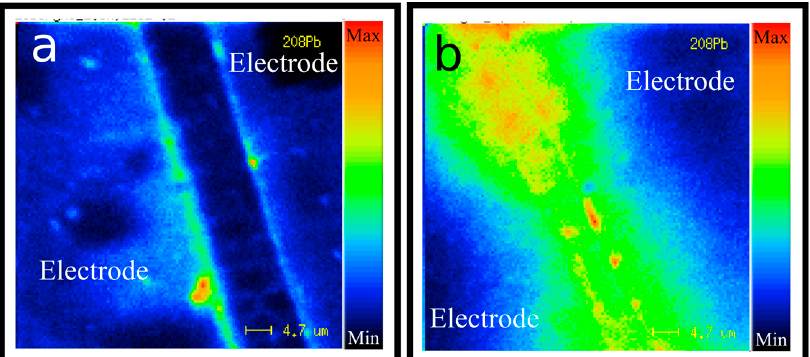
Figure 2. NanoSIMS imaging of the nanoribbons based device. 208 Pb tracking after 15 min exposure to lead solution before ( a ) and after ( b ) grafting process. Functionnalization enables preconcentration of Pb ions at the surface of nanoribbons.